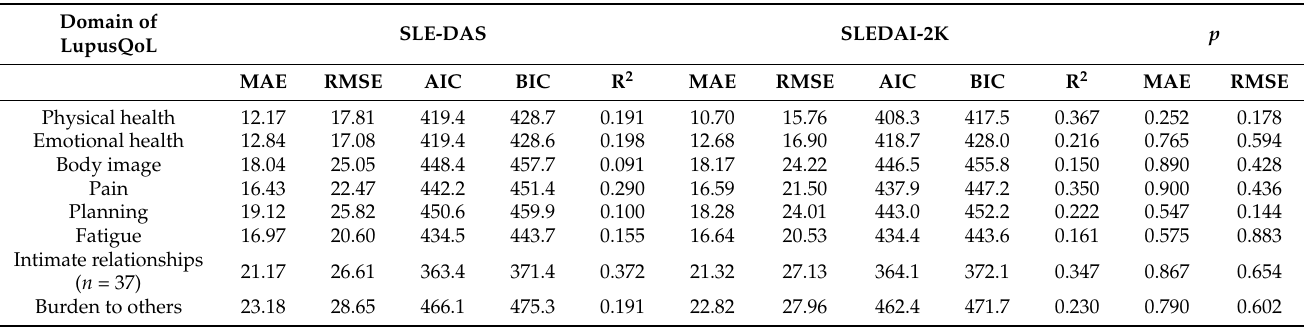
Burden to others